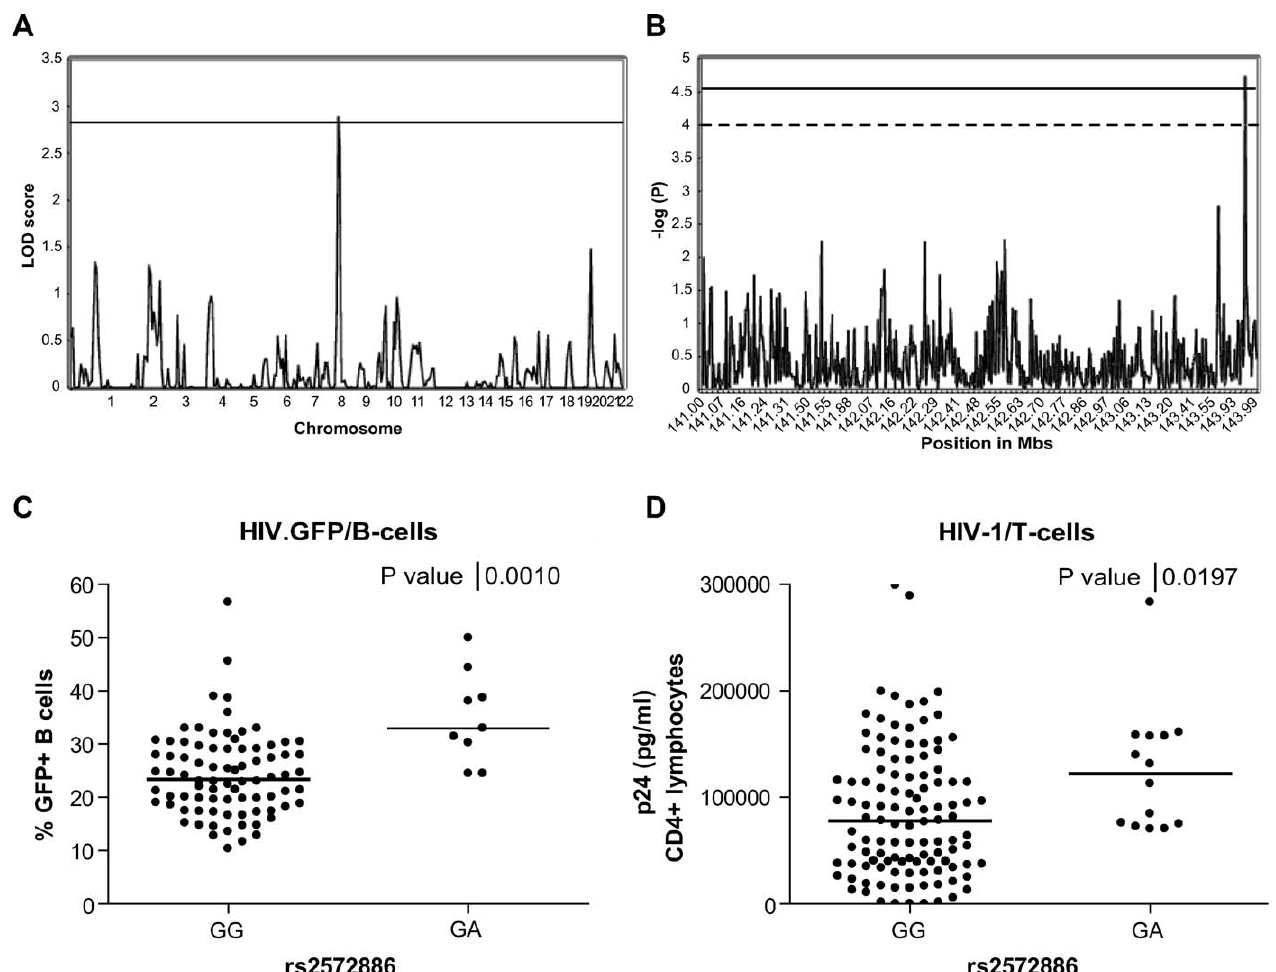
Figure 2. Genome Scan and Fine Mapping of an HIV-1 Susceptibility Locus, and In Vitro Validation of the Candidate SNP Marker (A) Linkage analysis with 15 families and 2,600 markers identifies a quantitative trait locus (QTL) on HSA8q24.3. The highest multipoint LOD score of 2.89, p ¼ 1.3 3 10 (cid:2) 04 (marker rs1398296) was significant at genome-wide level as determined by permutation analysis (95% significance threshold of 2.83, dotted line). (B) Association analysis in 56 unrelated individuals, using 521 SNPs from the HapMap project centered 3 Mb around the initial QTL, identifies marker rs2572886 ( p ¼ 1.8 3 10 (cid:2) 5 ). The association remained significant after correction for multiple testing by Bonferroni (dashed line) or permutation analysis (dotted line). (C) The candidate marker is associated with a significant 1.4-fold increase in susceptibility to the HIV.GFP. (D) rs2572886A is associated with a significant 1.6-fold increase in susceptibility of CD4 þ T cells from healthy blood donors to replicating HIV-1, differences between the alleles remain significant ( p ¼ 0.0331) after removing the outliers.